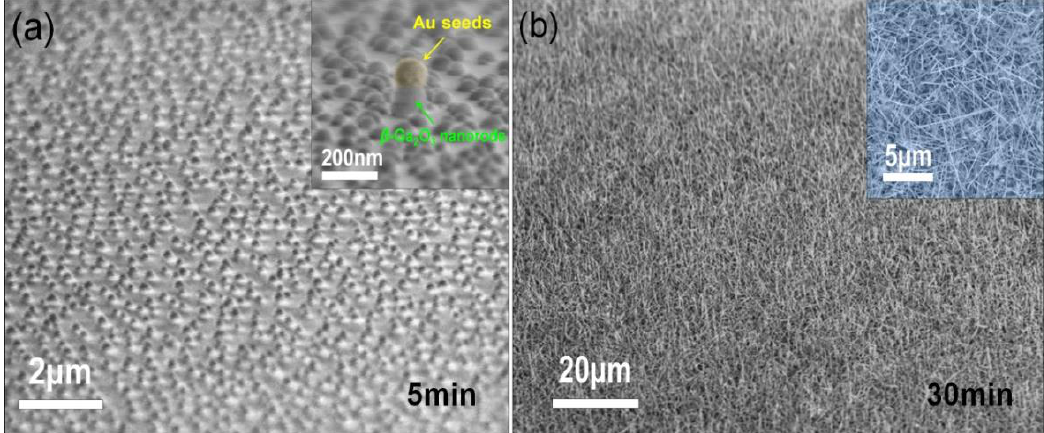
Figure 2. Scanning electron microscopy (SEM) images illustrating the growth process of β -Ga 2 O